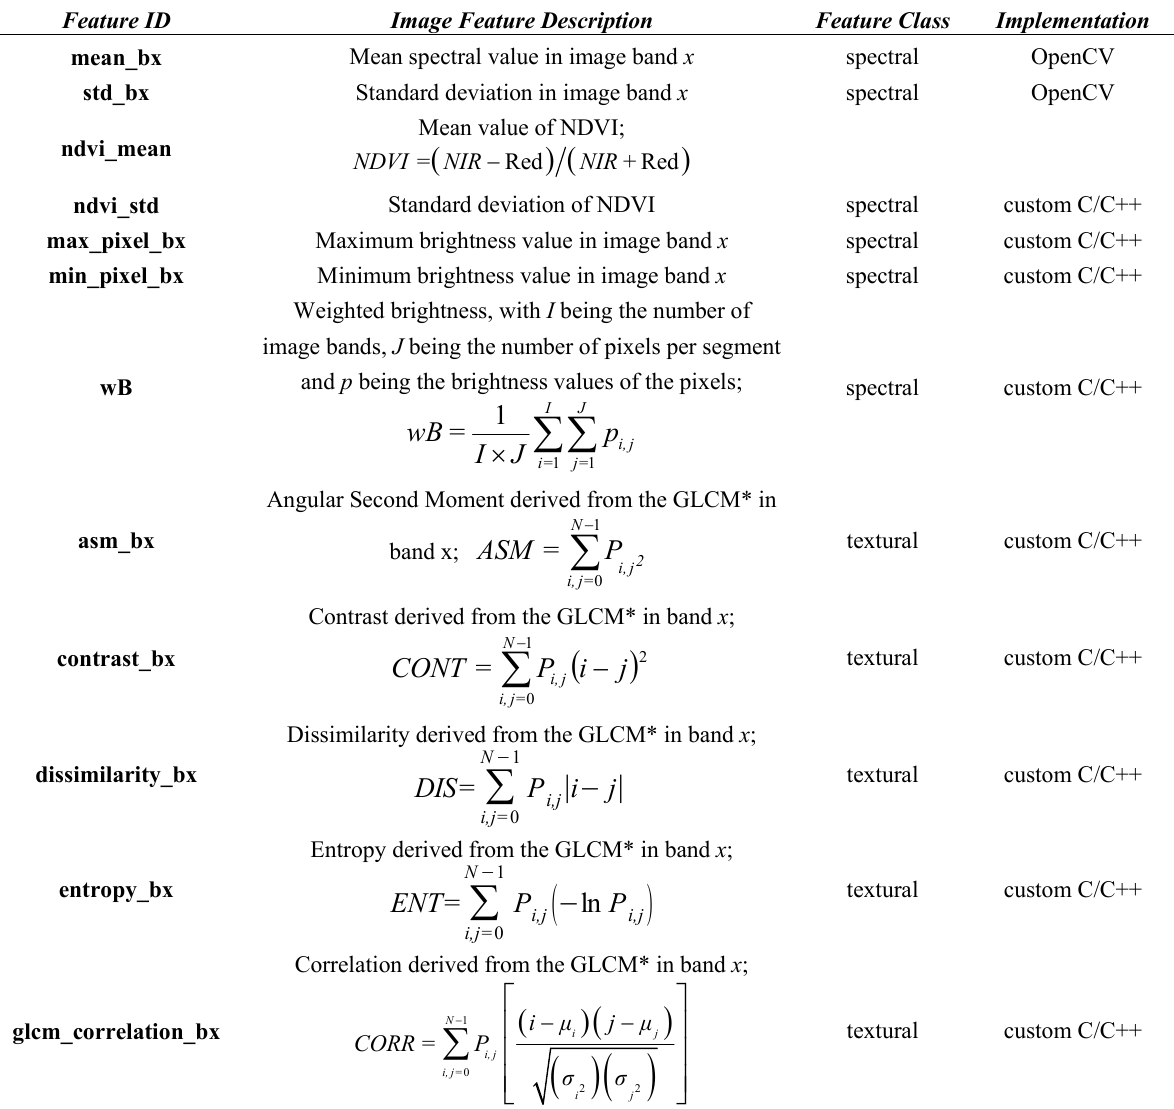
Table 2. List of image features (part I of II). All image features are computed per segment. Feature ID Image Feature Description Feature Class Implementation Mean spectral value in image band x spectral